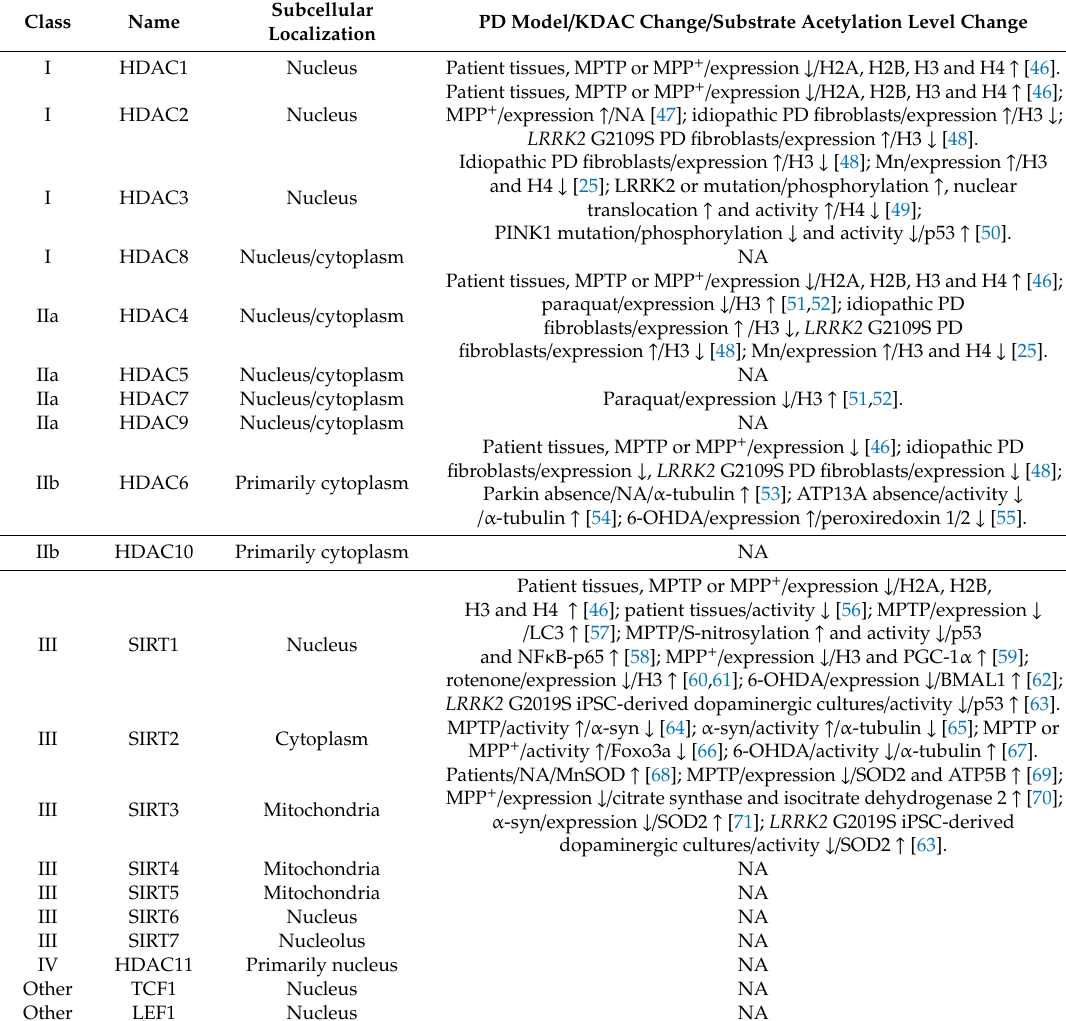
Table 3. Human KDACs and their Involvement in